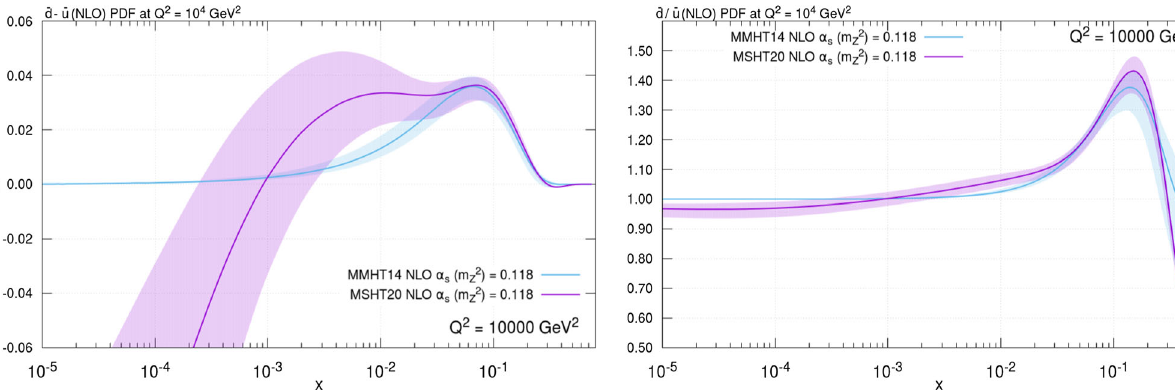
Fig. 33 (Left) ¯ d − ¯ u and (right) ¯ d / ¯ u PDFs at NLO and Q 2 = 10 4 GeV